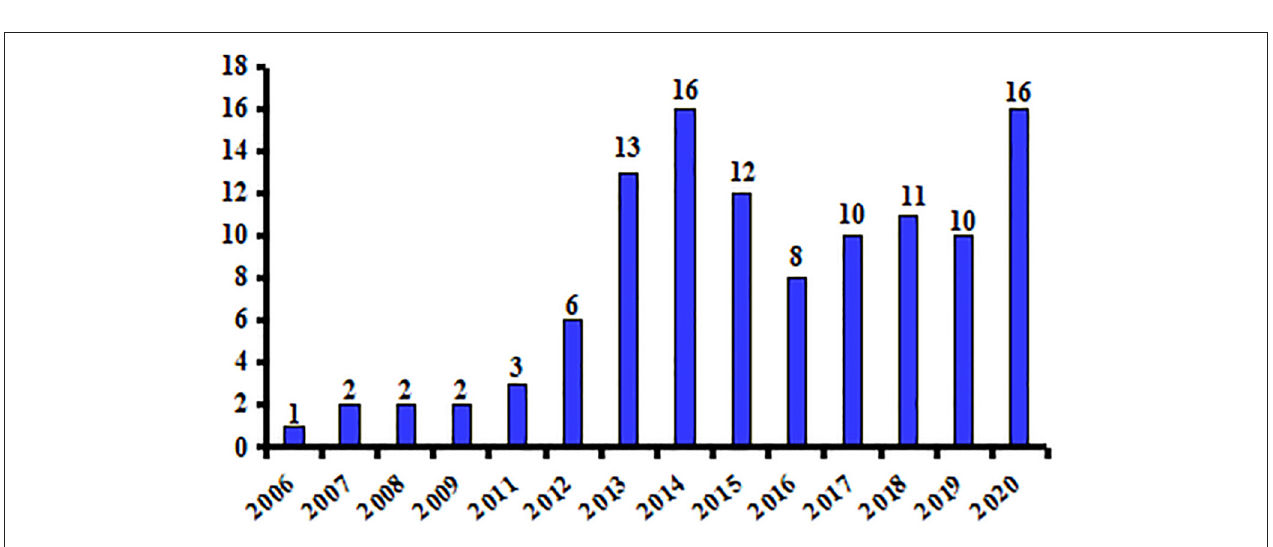
FIGURE 2 | Numbers of MRI studies of acupuncture in